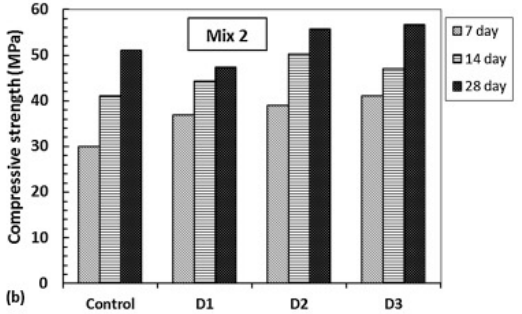
Figure 6. Compressive strength of 3D printed samples at different direction loading. (Reproduced with permission from: [7], Archives of Civil and Mechanical Engineering; published by Science Direct, 2018).